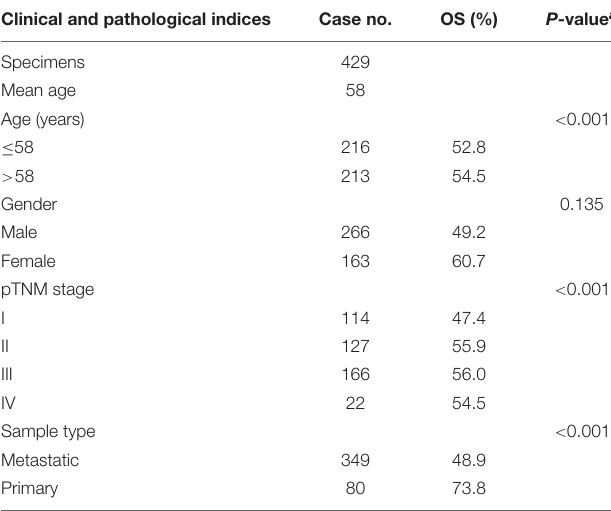
TABLE 1 | Clinicopathological characteristics of 429 skin cutaneous melanoma patients in The Cancer Genome Atlas dataset. Clinical and pathological